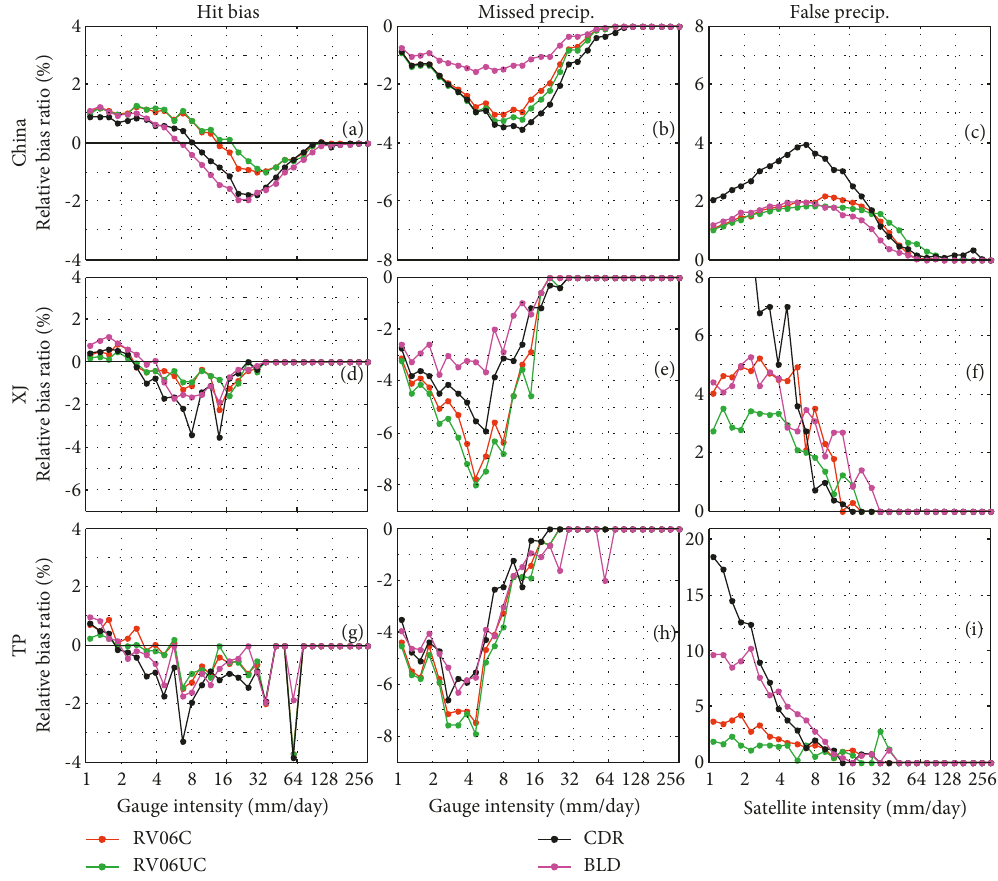
Figure 21: Same as Figure 18, but for winter